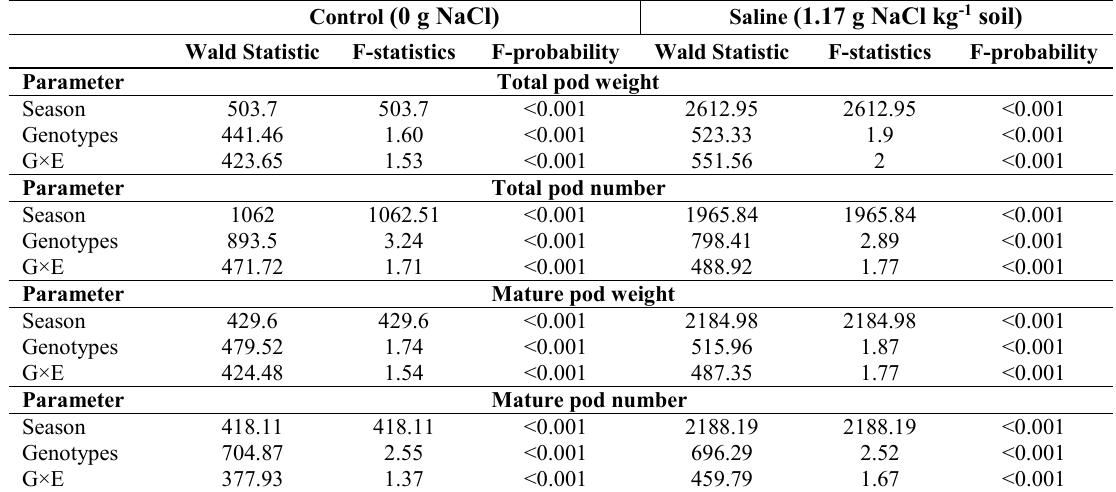
Table 4. Analysis of variance for yield parameters (pod weight, pod number, mature pod weight, mature pod number) across the two season when yield was assessed (2006 and 2006-2007)